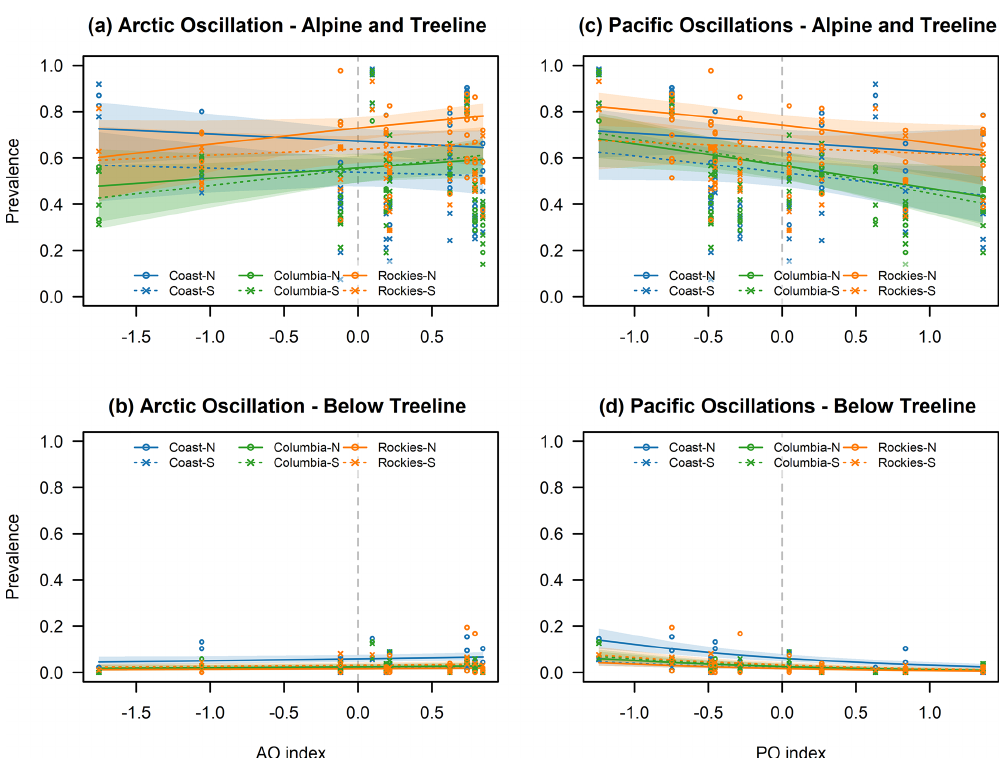
Figure 6. Calculated prevalence for wind slab avalanche problems in relation to AO (a, b) and Pacific-centered oscillations (c, d) for the alpine/treeline (a, c) and below treeline (b, d) over the range of observed index values. Lines indicate the mean estimates, and shaded areas represent the 95% confidence intervals. Individual points represent observed prevalence